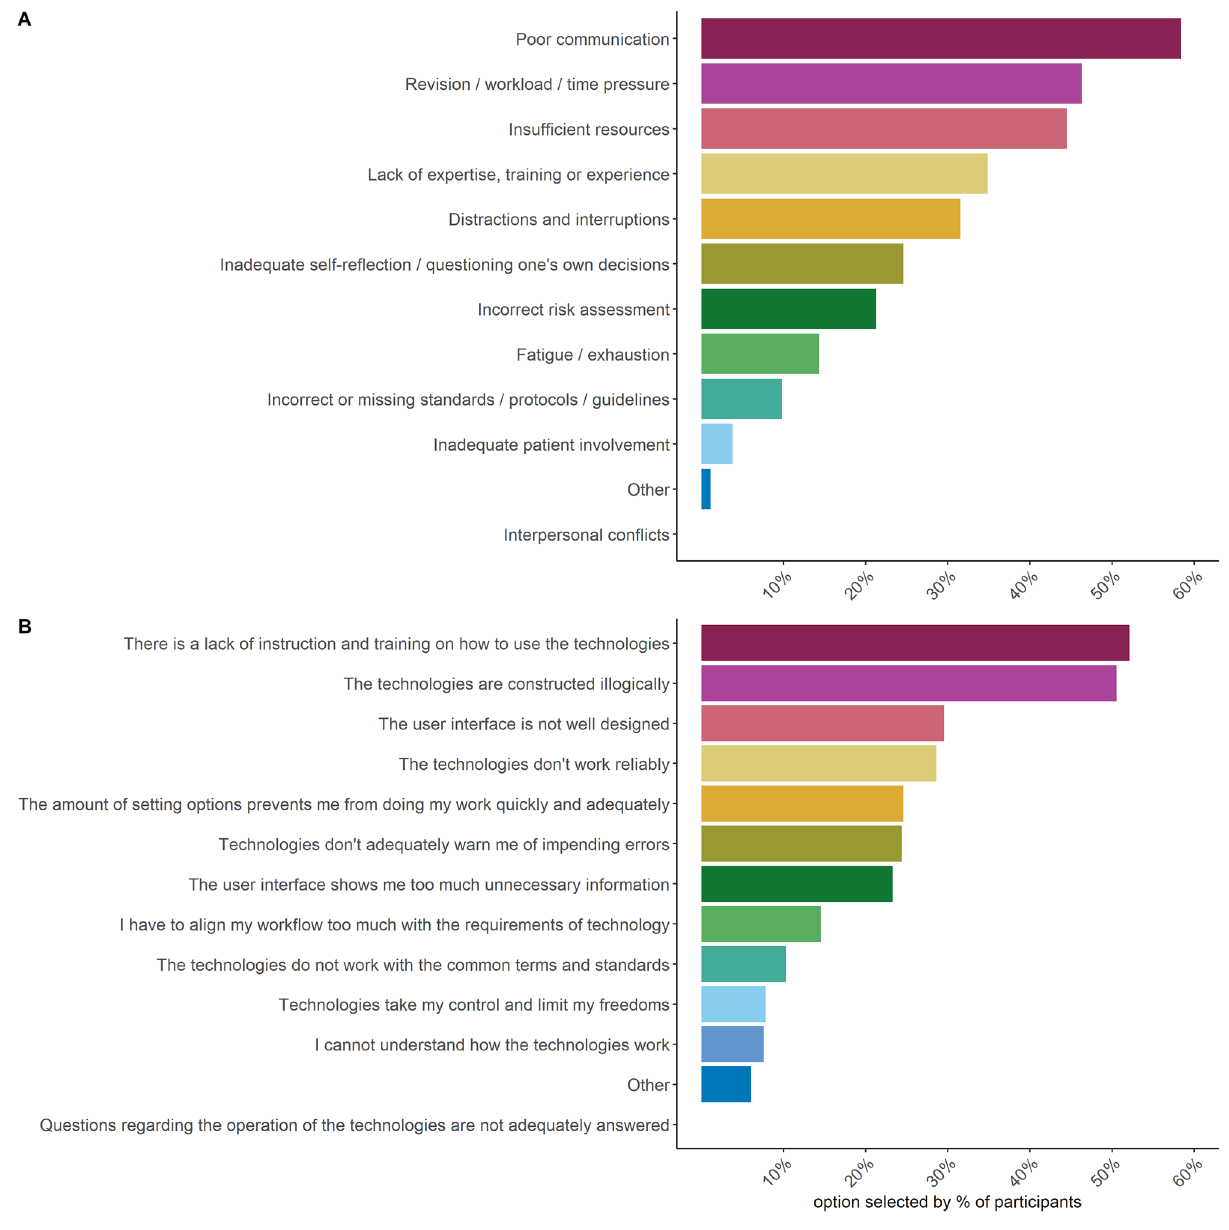
Figure 3. Distribution of participants’ selected top causes of medical errors on ( A ) an individual and organizational level and on ( B ) a technological